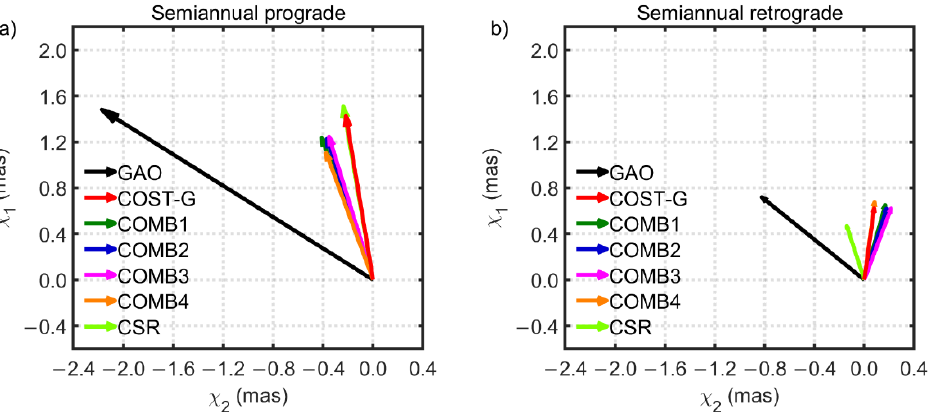
Figure 9. Phasor diagrams of semiannual prograde ( a ) and semiannual retrograde ( b ) variation in complex series (χ 1 + iχ 2 ) of gravimetric excitation and GAO. Phase (φ) is defined by the semiannual term as sin(4π(t − t 0 ) + φ), where t 0 is the reference epoch (1 January 2004). The similar phasor diagrams drawn for semiannual prograde and semiannual retro- grade oscillations show that the semiannual retrograde variation is very weak for both GAO and gravimetric excitation (Figure 9). The results for COMB solutions are congruous; the amplitude differences with respect to GAO are between 1.33 and 1.47 mas for the prograde term and between 0.41 and 0.45 mas for the retrograde term, while the phase discrepancies are as high as 37–40 ◦ and 56–63 ◦ for the prograde and retrograde oscillation, respectively. Since the amplitudes of terannual oscillations turned out to be very small (Figure 4), they are not analysed in our